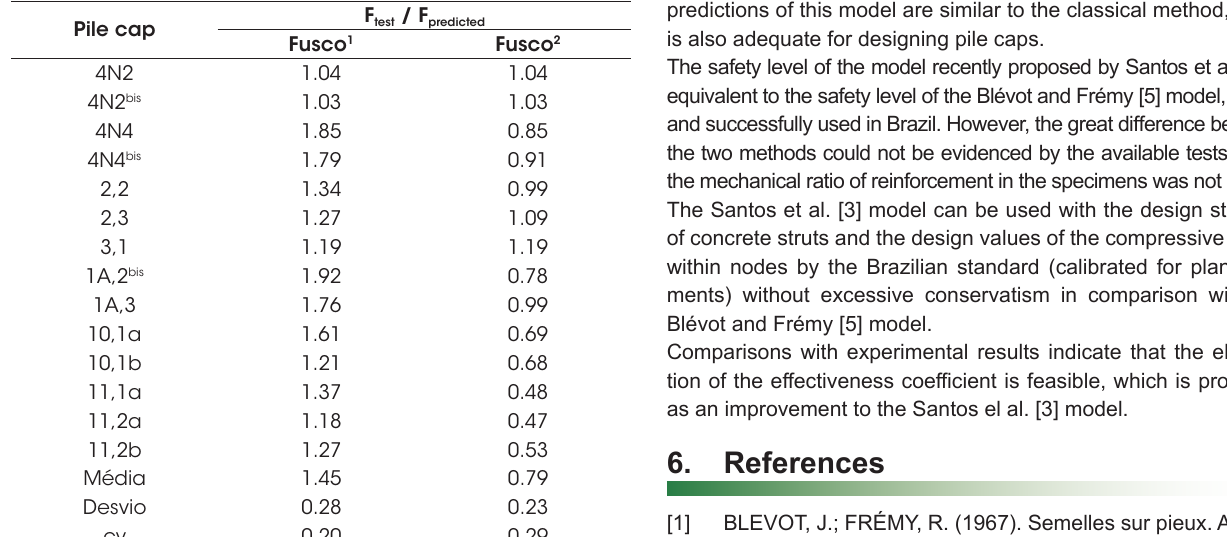
Comparisons between the Fusco model and experimental results of Blévot & Frémy